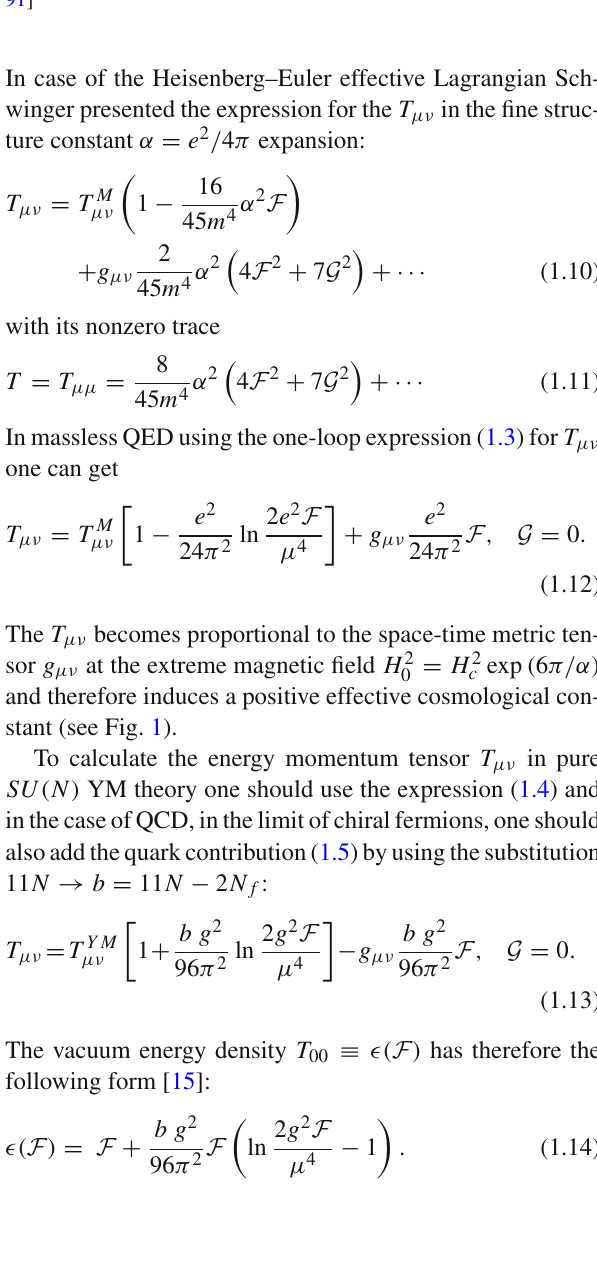
Fig. 1 The graph shows the qualitative behaviour of the QED vacuum energydensity (cid:8)( (cid:5) H 2 ) (1.3),(2.19)andoftheeffectivecouplingconstant ¯ e 2 ( (cid:5) H 2 ) (4.3) as the functions of the background magnetic field. The effective coupling constant is singular at (cid:5) H 02 , the “Moscow zero” [90, 91]